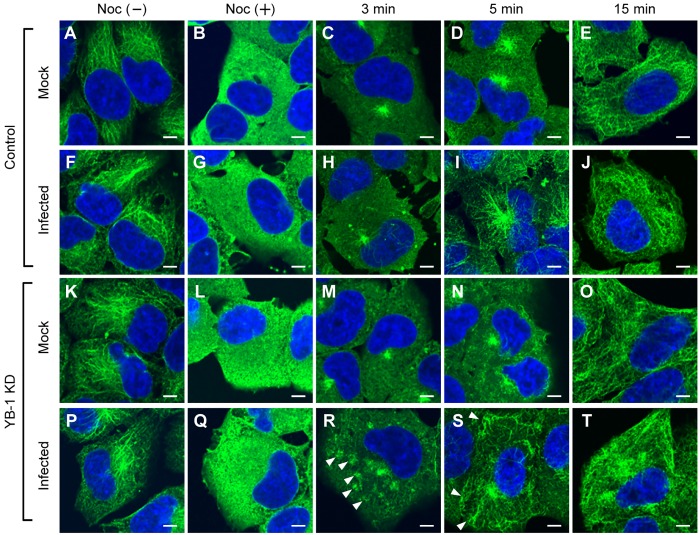
Microtubule nucleation after releasing from nocodazole treatment.At 48 h post transfection with either non-targeting (panel A-J) or YB-1 siRNA (panel K-T), HeLa cells were infected with influenza virus at MOI of 10. At 8 h post infection, cells were treated for 1 h without (Noc(-)) or with 1 μg/ml of nocodazole (Noc(+)). At 3 (panel C, H, M, and R), 5 (panel D, I, N, and S), and 15 min (panel E, J, O, and T) post releasing from nocodazole treatment, cells were fixed and subjected to indirect immunofluorescence assays with mouse anti-α-tubulin antibody. Arrowheads indicate the microtubules sporadically localized at the peripheral cytoplasm (panel R and S). Scale bar, 5 m.